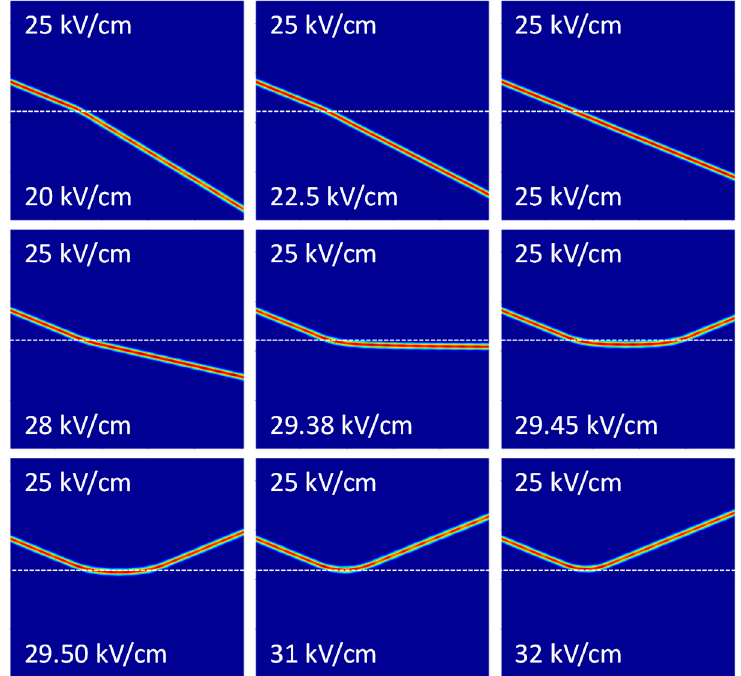
Figure 3. Reflection and refraction dynamics of a soliton beam at an ideal electric interface. The dotted line identifies the position of the electric wall. The applied biases at the two volumes before and after the wall are reported in each case.